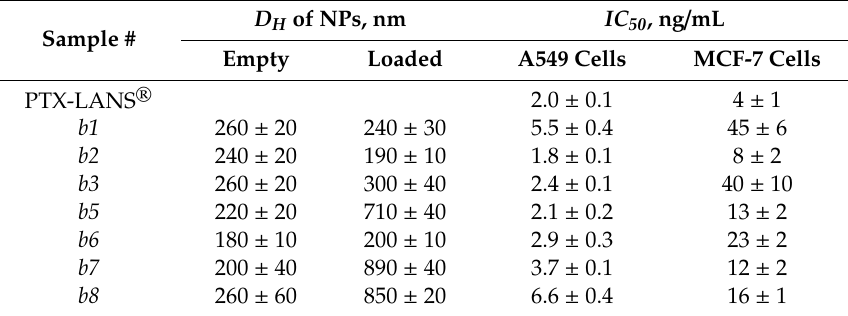
Table 5. Characteristics of empty and paclitaxel-loaded PMAG- b -PAA NPs and cytotoxic e ff ect of encapsulated forms of